Question: From the figure, is the trend upward or downward?
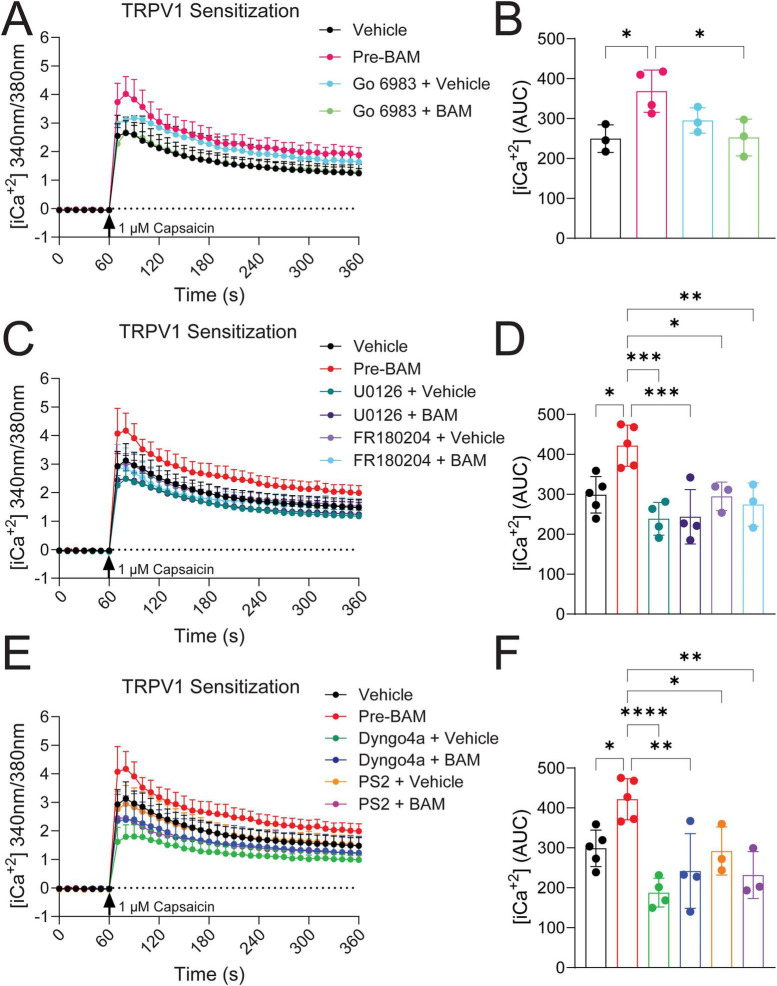
Answer: decreasing